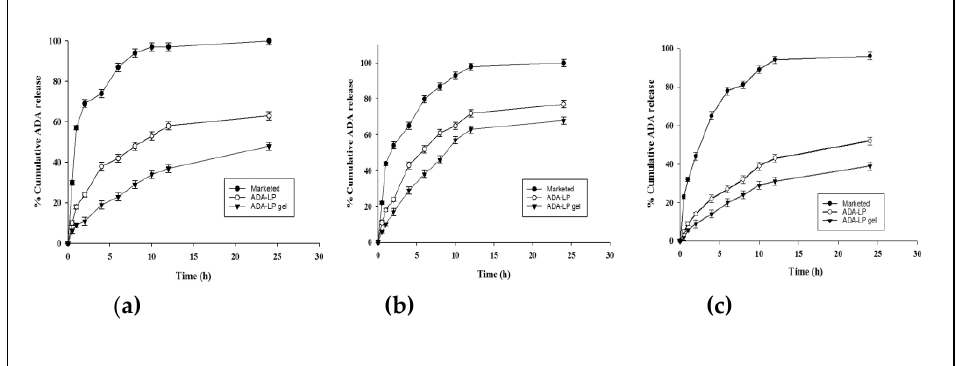
Figure 6. In vitro release study at pH ( a ) 5.5, ( b ) 6.4, and ( c ) 7.4 where p = < 0.05.